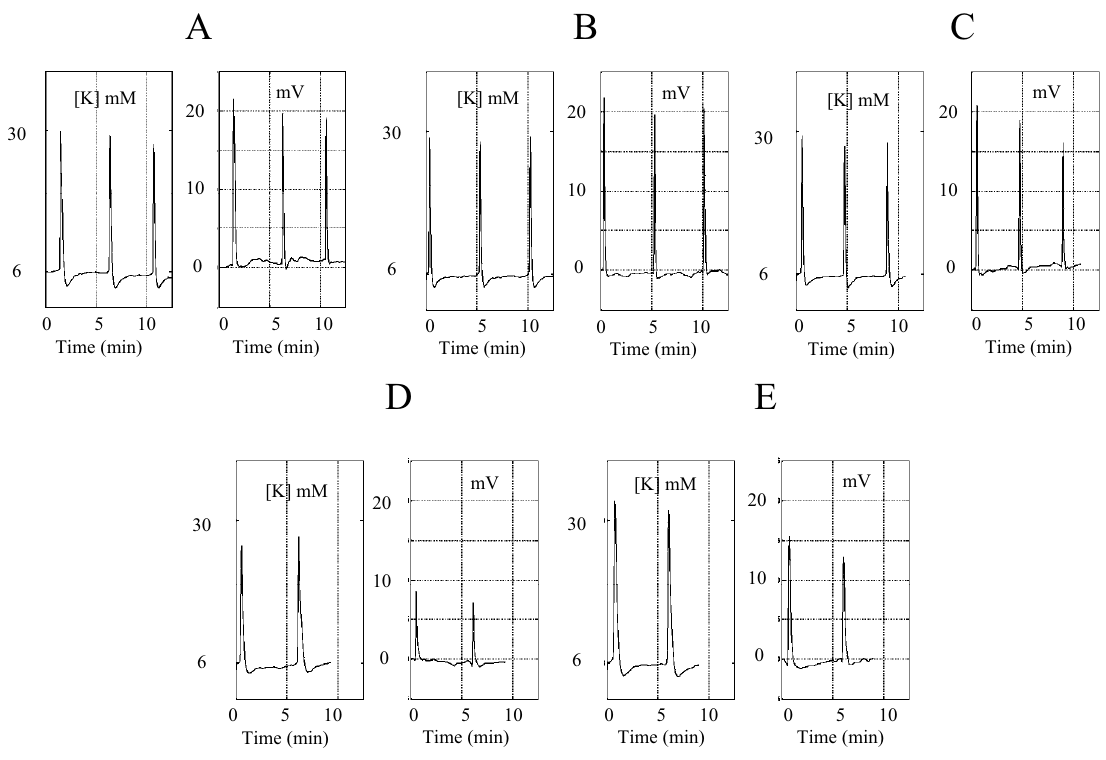
Fig. 5 – Wave propagation corresponding to the intervals of Figure